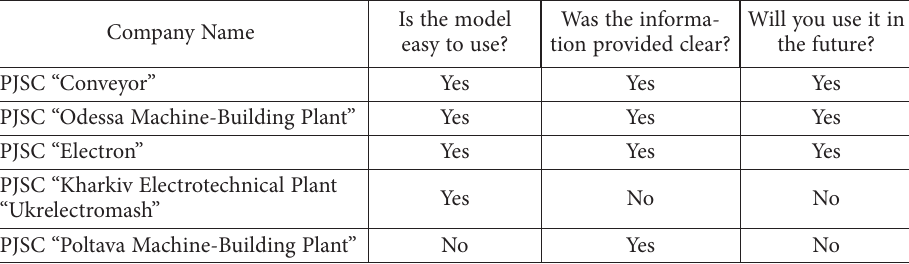
Table 2. Results of a survey of leaders of teams and departments for innovation and development at industrial enterprises of Ukraine regarding the effectiveness of our model Is the model Company Name easy to